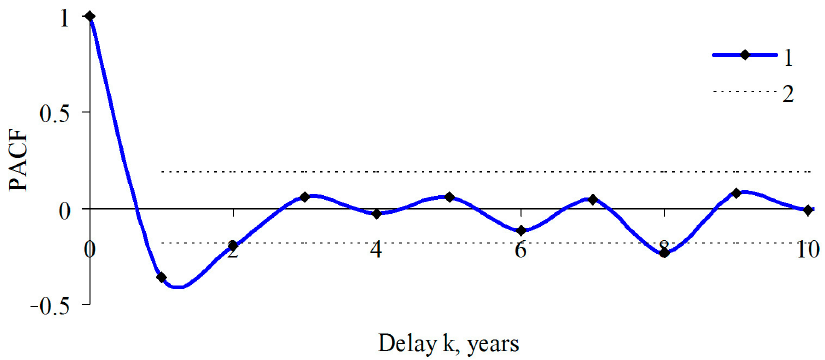
Figure 3. Partial autocorrelation function of the time series (TRW FD) of the average radial stem growth for the trees on sample plot 1. Here, 1–partial autocorrelation function (PACF), 2–standard error of